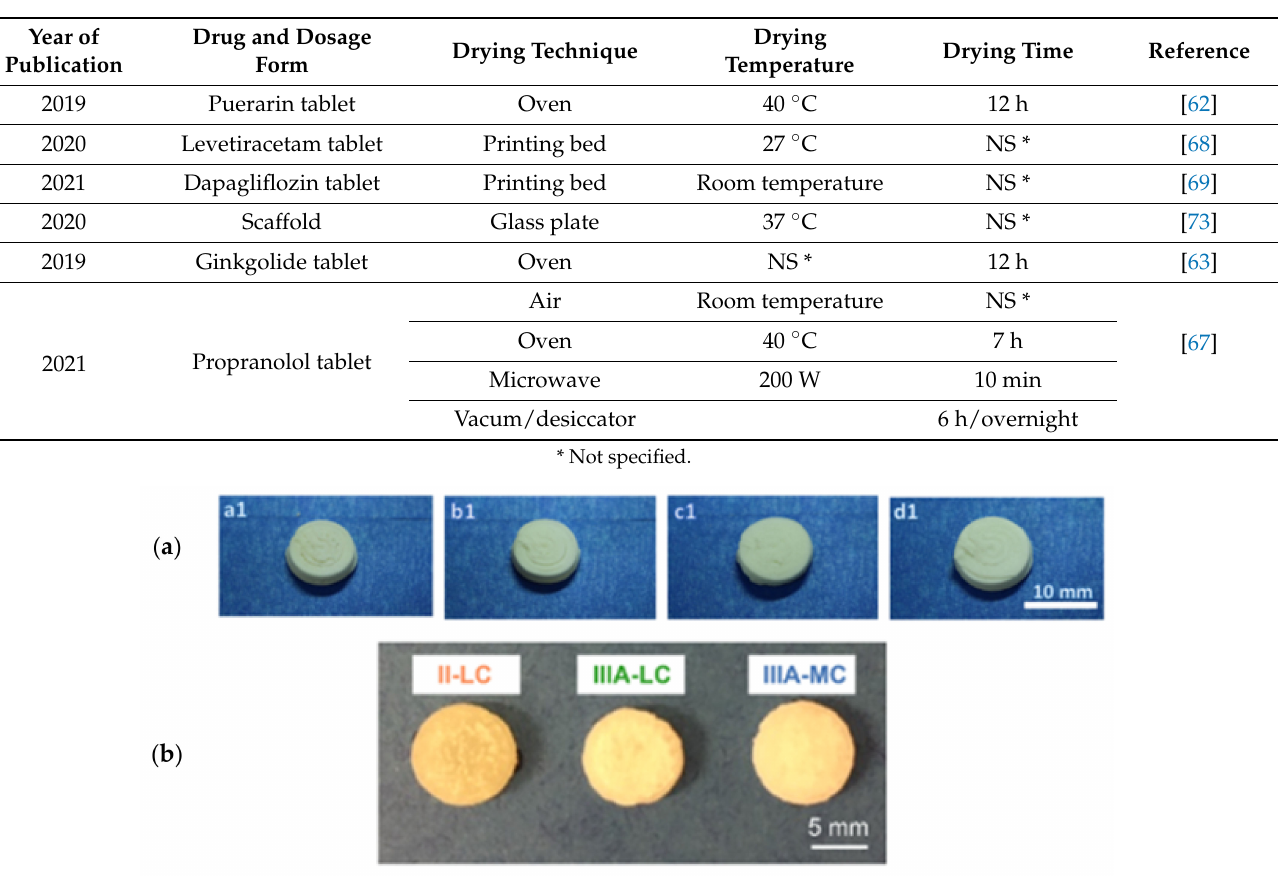
Figure 15. 3D-printed tablets of ( a ) theophylline (dried at 50 ◦ C) (( a1 ) PVA and sorbitol, ( b1 ) PVA and lactose and ( c1 ) PVA and D-mannitol and ( d1 ) PVP and lactose) and ( b ) scaffold (dried using vacuum flask at room temperature). Images reproduced with permission from [56,57]. Copyright Elsevier,